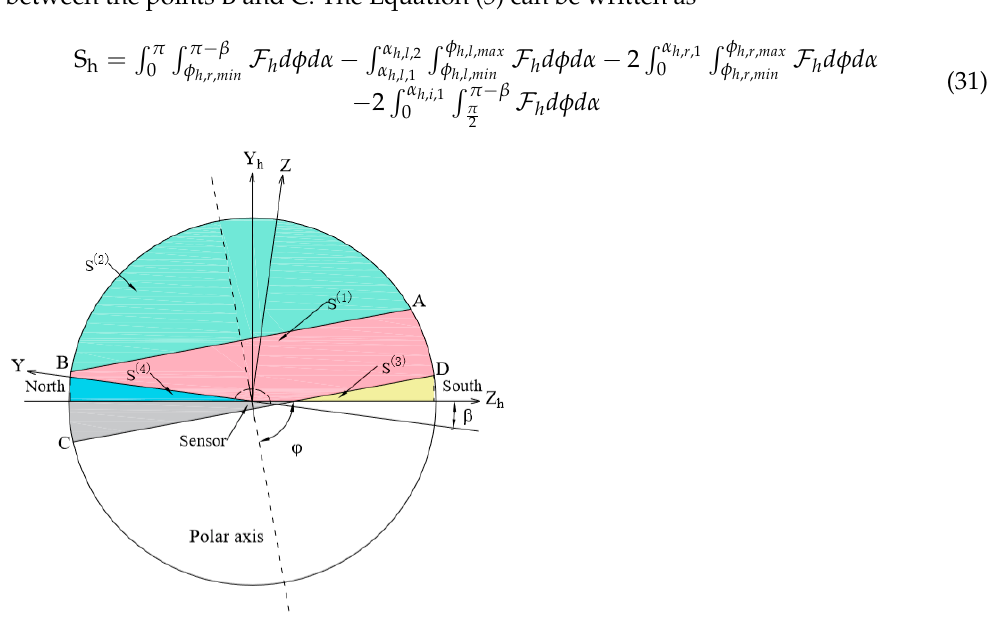
Figure 10. Schematic diagram for the calculation of 𝑆 (cid:3035) while 𝑑 (cid:3045) ≤ 0 , 𝑦 (cid:3035),(cid:3004) > 0 and 𝜙 (cid:3035),(cid:3045),(cid:3040)(cid:3028)(cid:3051) < 𝜋 − 𝛽 .